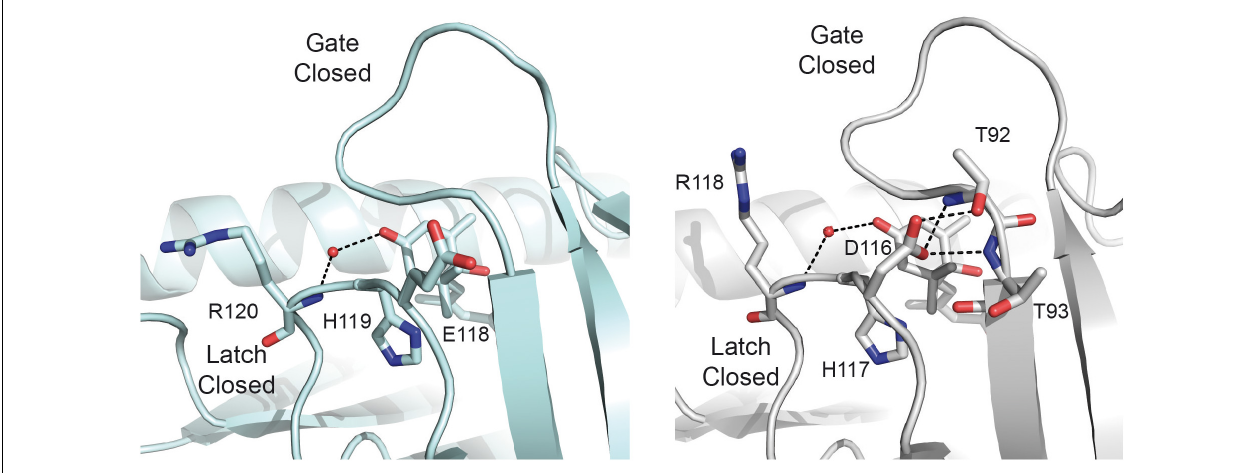
FIGURE 6 | Asp at the latch contributes to the stabilization of the closed conformation of the gate. A section of the structures of dimeric AtPYL2-ABA (left) and monomeric AtPYL9-ABA (right). Selected hydrogen bonds are highlighted as dashed